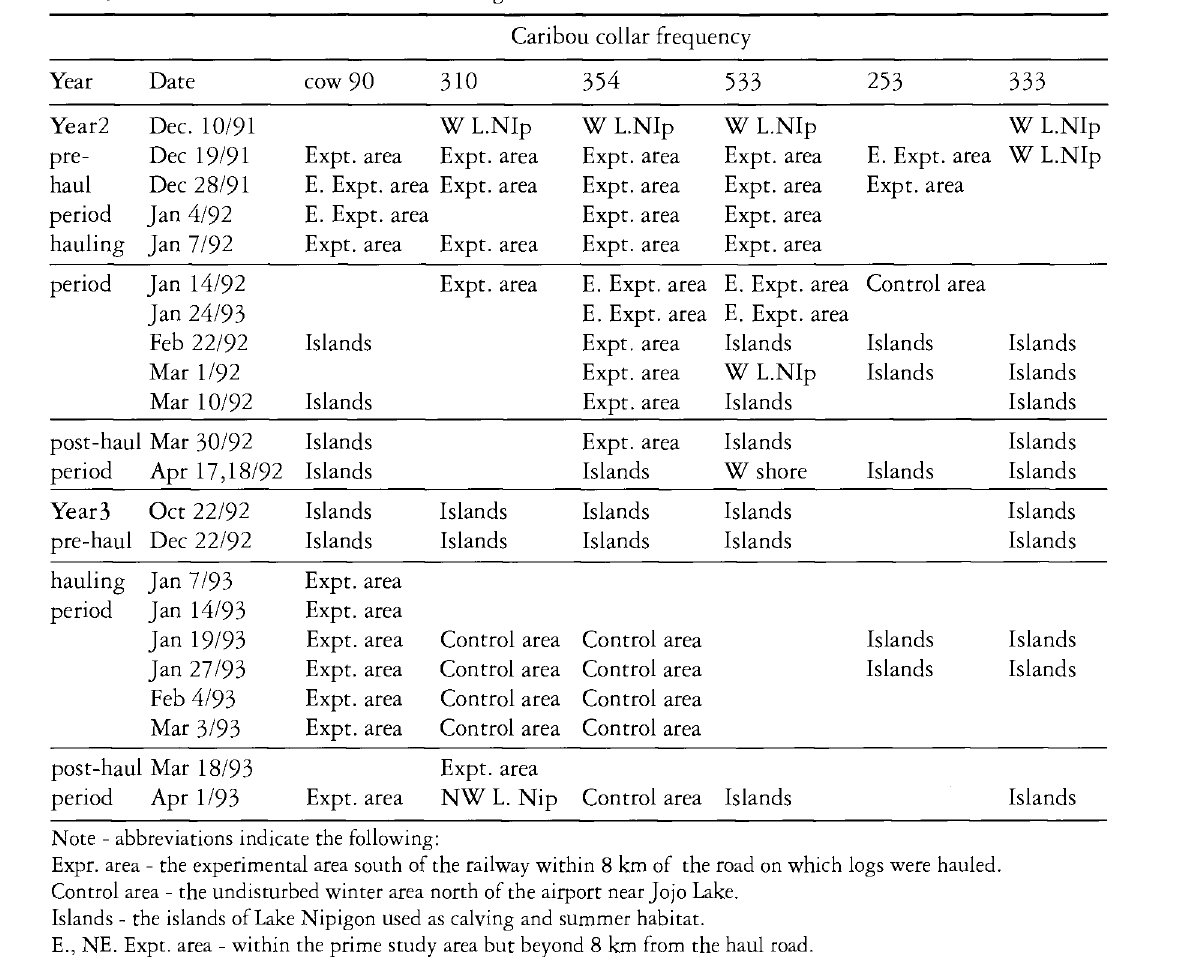
Table 3. Locations of radio collared caribou during 2